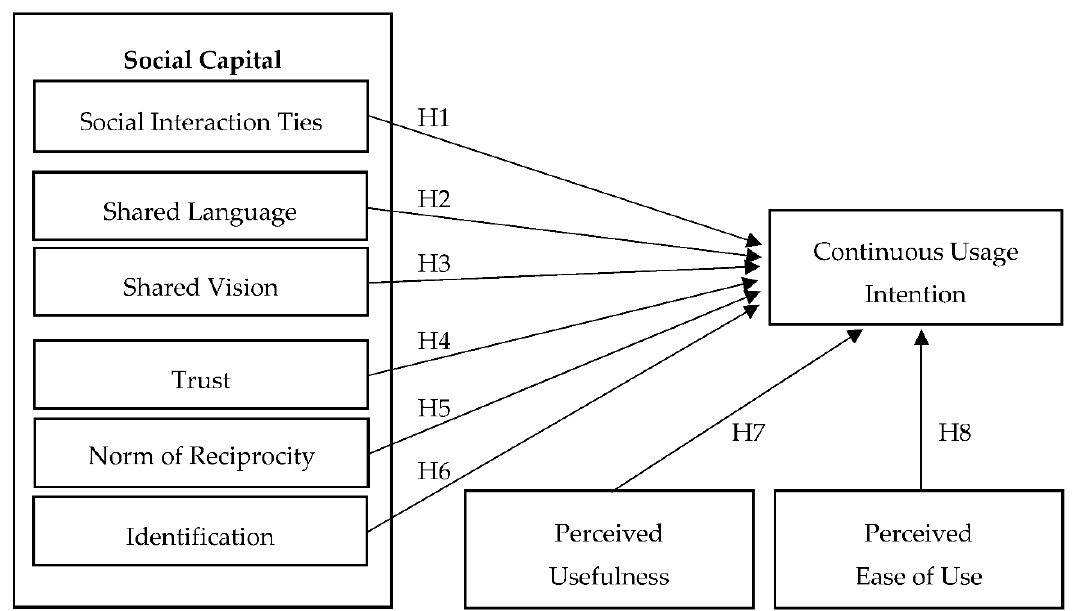
Figure 1. Research model.